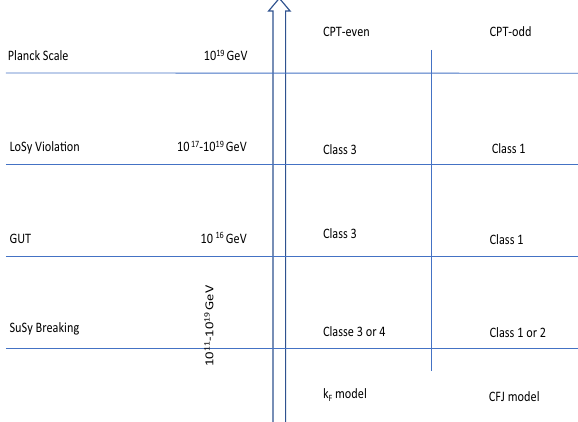
Fig. 1 We show the energy scales at which the symmetries are sup- posedtobreak,referringtothemodeldescribedin[55].AtPlanckscale, 10 19 GeV, all symmetries are exact, unless LoSy breaking occurs. This latter may intervene at a lower scale of 10 17 GeV, but anyway above GUT. Between 10 11 and 10 19 GeV, we place the breaking of SuSy. In our analysis, we assume that the four cases of SuSy breaking occur only when LoSy has already being violated. Interestingly, at our energy levels, we can detect the reminiscences of these symmetry